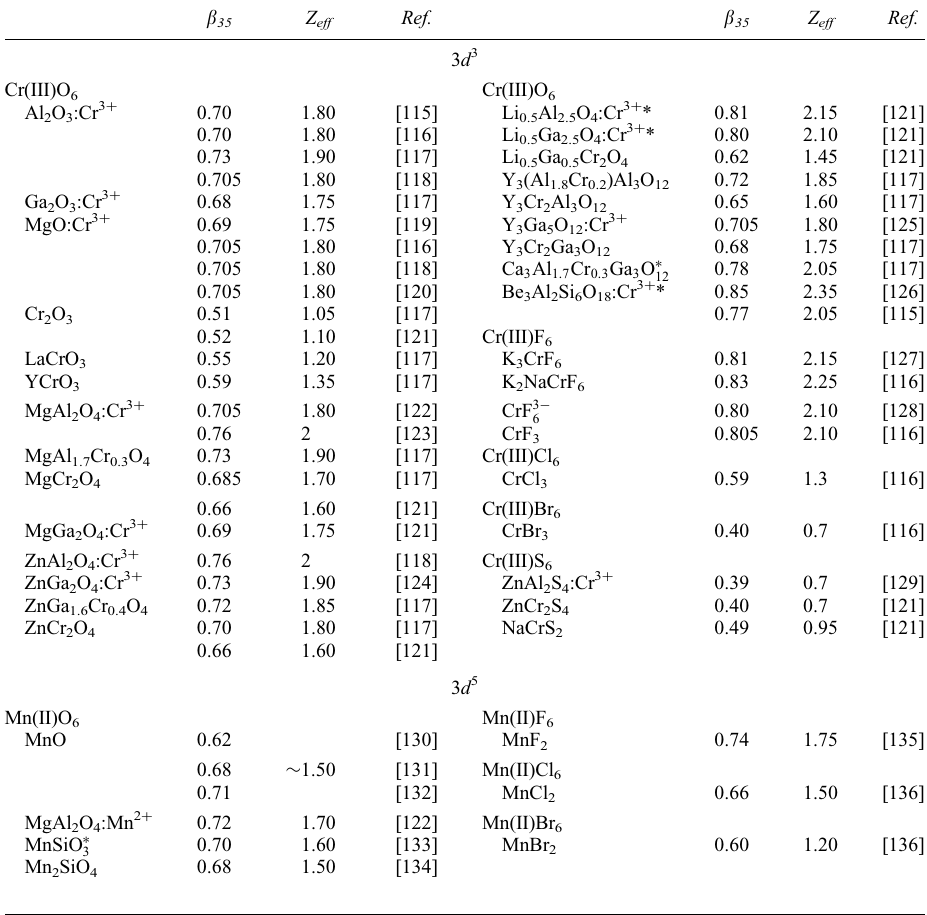
TABLE VI (a) Nephelauxetic Ratios b and Charges Z eff (According to the Jørgensen’s Compromise) Defined in the Text for Selected 3 d 3 and 3 d 5 Group Compounds. b 35